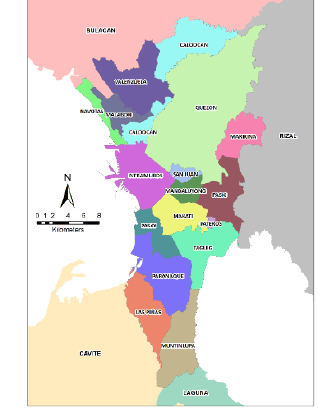
Figure 2. Map of cities in Metro Manila with the surrounding provinces (East: Rizal, North: Bulacan, South: Cavite and Laguna)